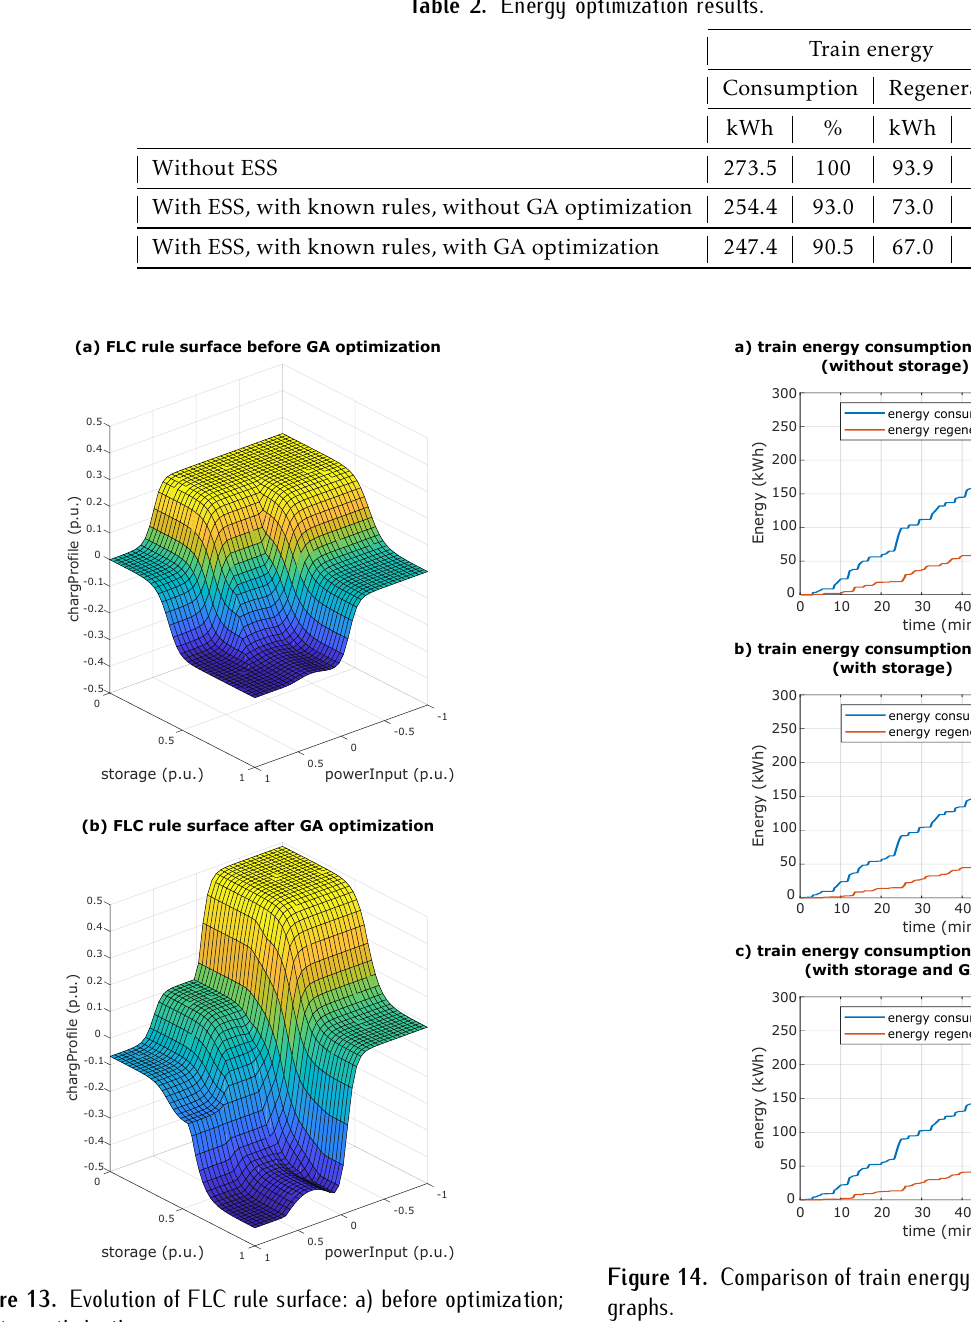
Figure 13. Evolution of FLC rule surface: a) before optimization; b) after optimization